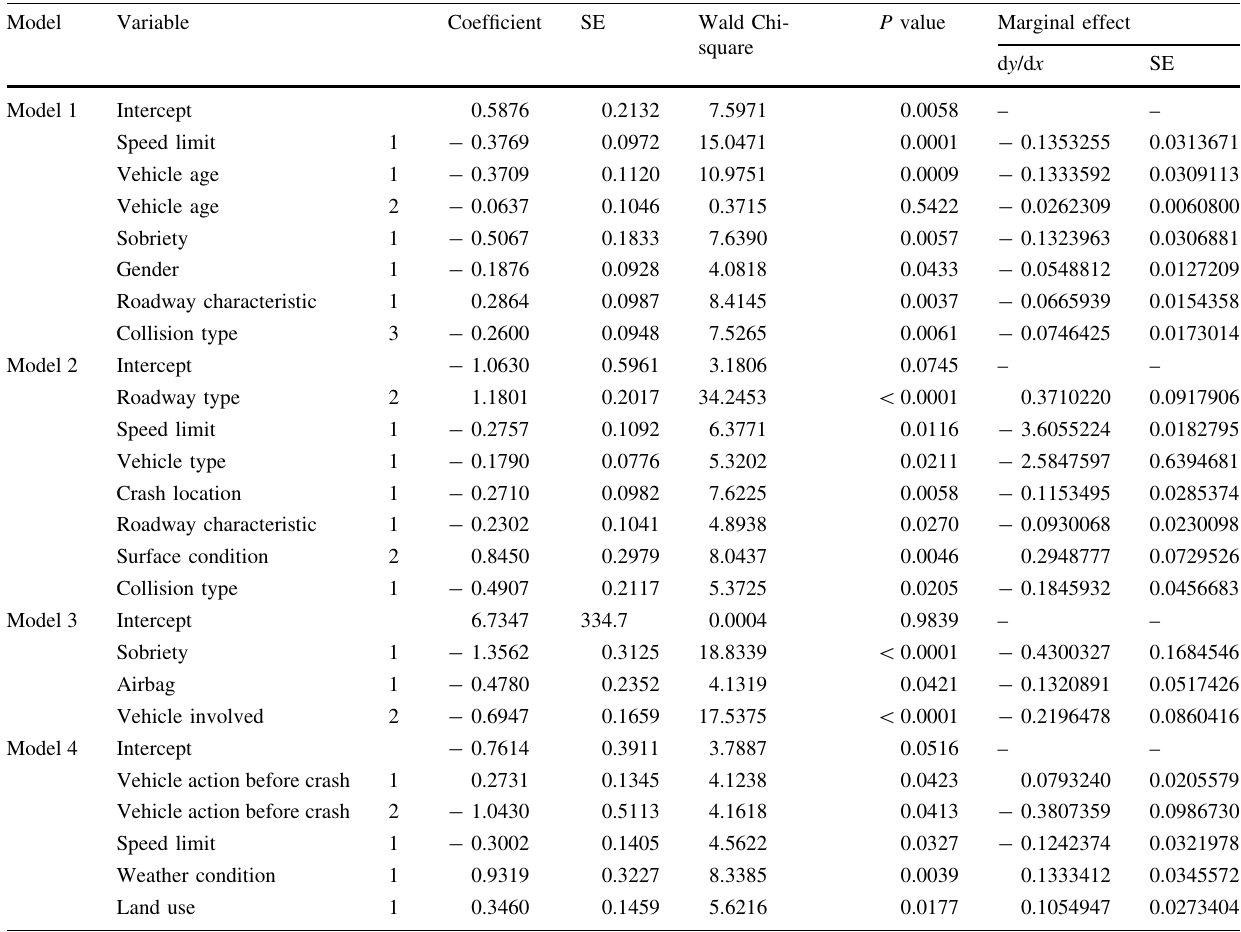
Table 2 Estimation of probit classification tree regression for work zone weather-related crash severity